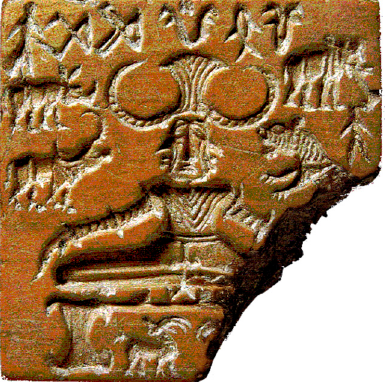
Figure 2. Paśupati seal (c. 2350 BCE): Harappan work depicting a theriomorphic priest in a yogic position and surrounded by animals. Seal #420, National Museum, New Delhi (free copyright). It is thought to be among the earliest evidence of yogic–ascetic practice in India.